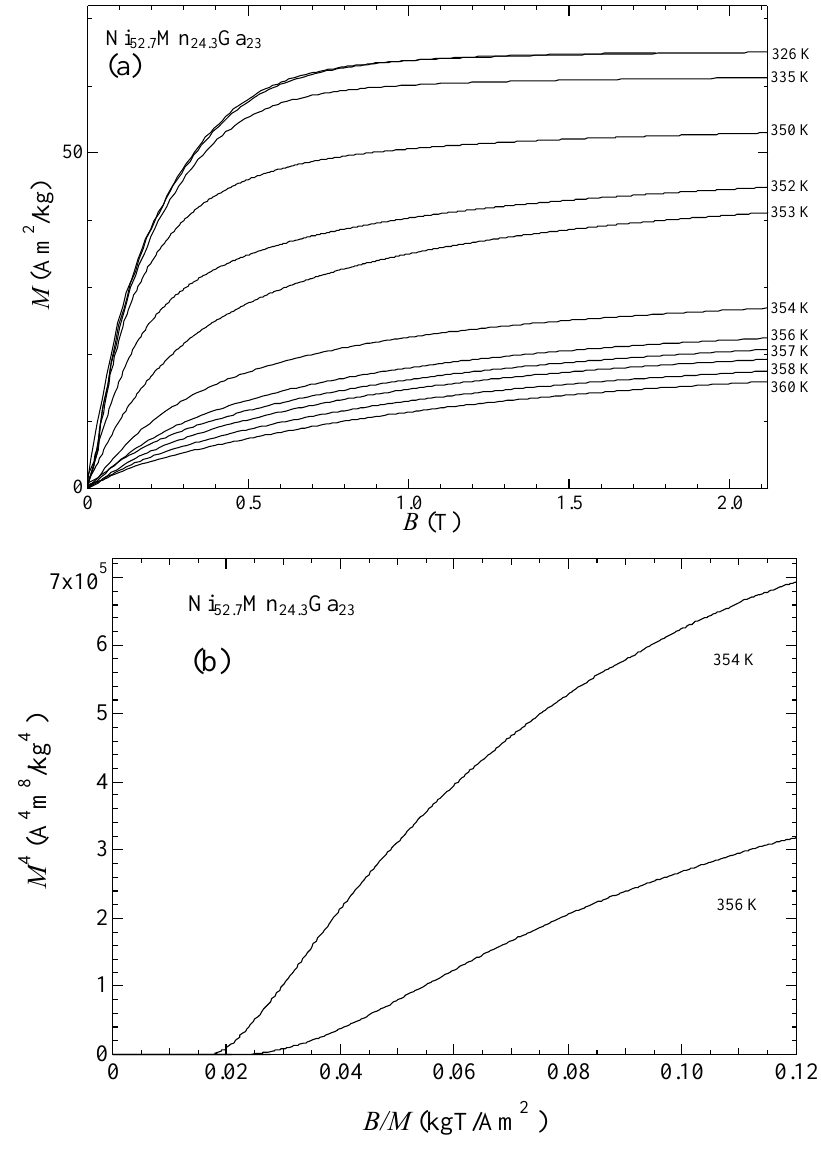
Figure 9. ( a ) Magnetization of Ni for Ni Mn Ga 52.7 24.5 23